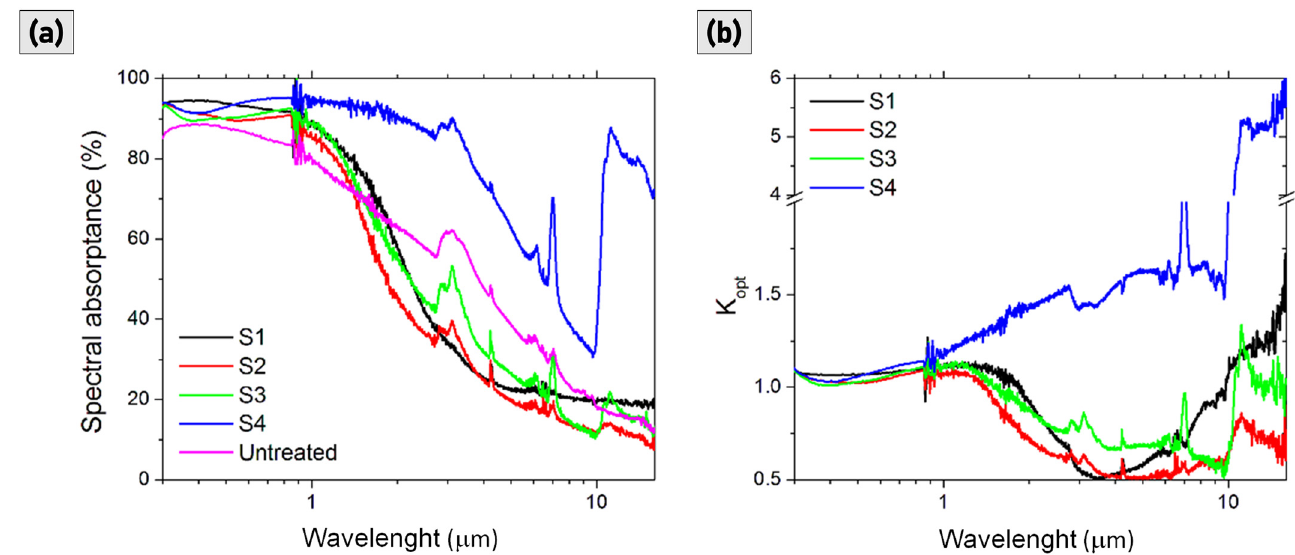
Figure 7. ( a ) Absorptance spectra of samples S1, S2, S3, S4, and for the untreated reference sample. ( b ) Absorptance enhancement, K opt , of samples S1, S2, S3 and S4.